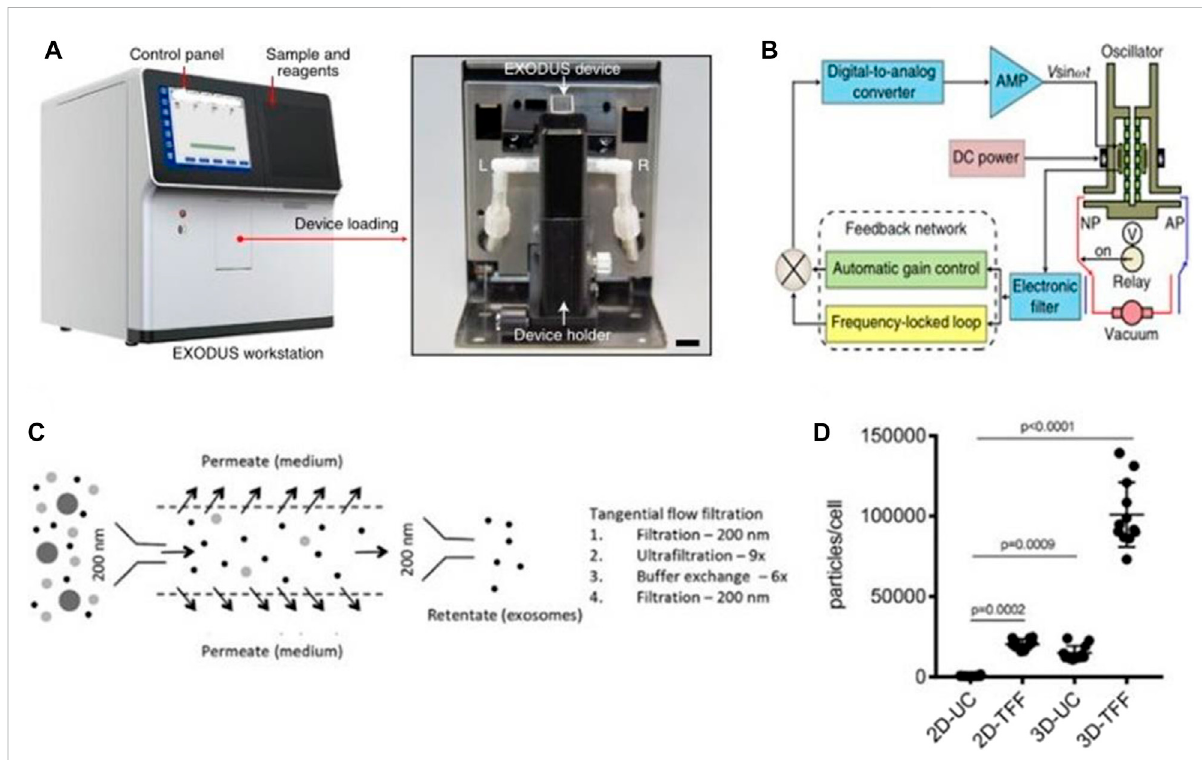
FIGURE 10 Exosomesseparationdevice. (A,B) AphotographoftheEXODUSstationandSchematicdiagramofthecontrolmodulefortheresonator(Chen et al., 2021). (C, D) Separation of exosomes by tangential fl ow fi ltration. Exosomes were enriched from the culture supernatant by tangential fl ow fi ltration with a 500 kDa cut-off fi lter cartridge (Haraszti et al.,